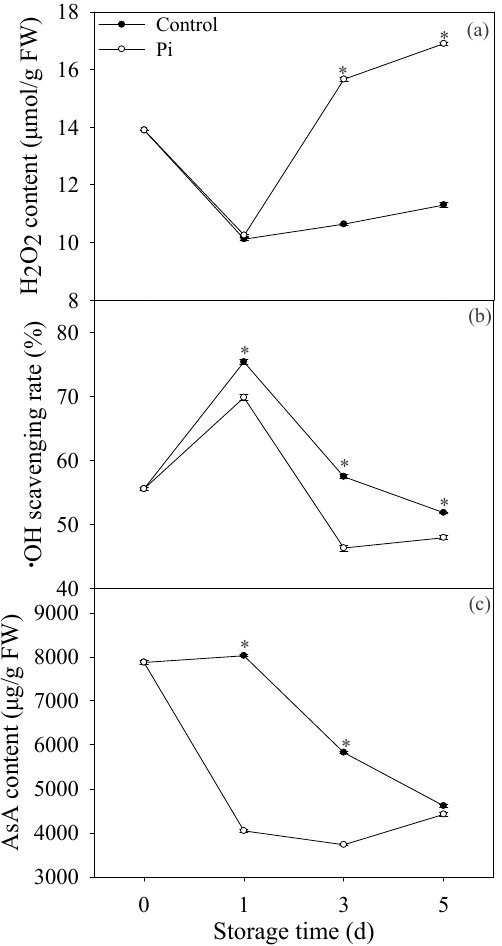
Figure 2. E ff ects of P. italicum infection on H 2 O 2 content ( a ), · OH scavenging rate ( b ), and ascorbic acid (AsA) content ( c ) of mandarin peel during storage at 25 ◦ C. Each data point represents a mean of three replicate assays ± standard error. Asterisks at the same storage time represented the significant di ff erences ( P < 0.05).